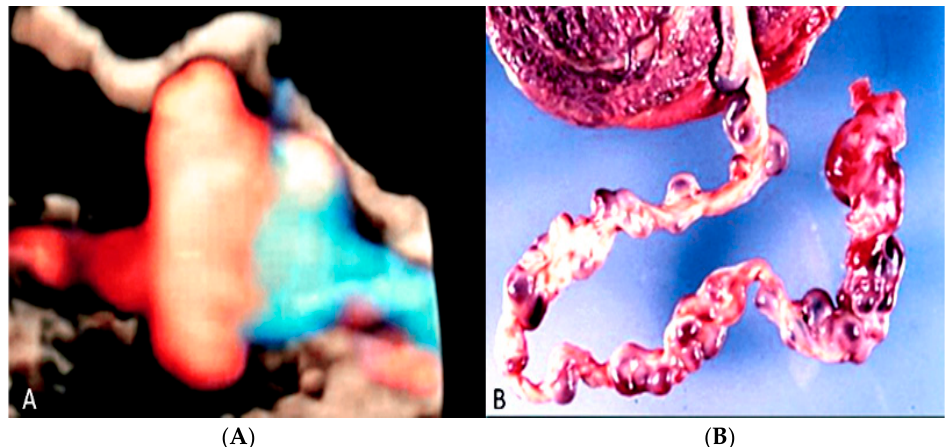
Figure 34. Sonographic view of umbilical cord vessel aneurism with color Doppler ultrasound ( A ). Gross anatomy: umbilical cord after delivery confirmed presence of multiples aneurisms ( B ).